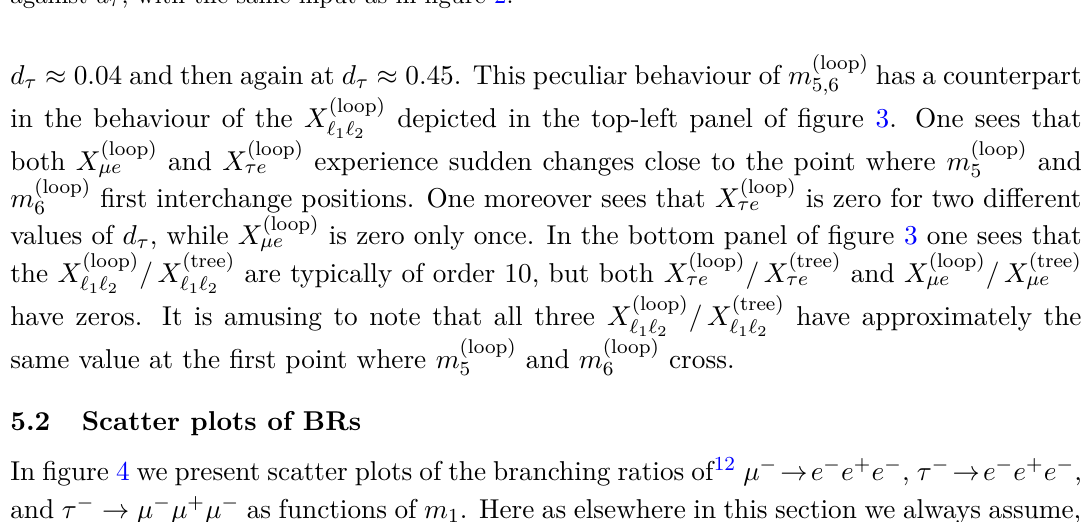
Figure 3 . X (loop) (top-left panel), X (tree) ‘ 1 ‘ 2 against d τ , with the same input as in figure